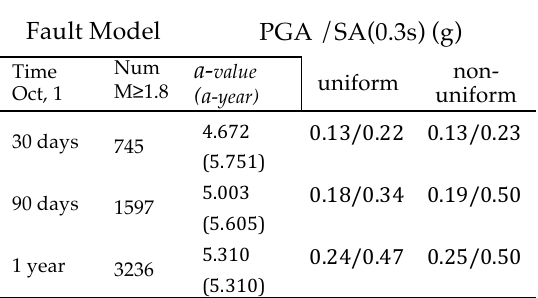
Table 1: APSHA, maximum PGA/SA at 10% probabil- ity of exceedance in different observation times since Oct, 1 st , 2016; values obtained with uniform and non-uniform partitioning of aftershock seismicity rates on the fault.